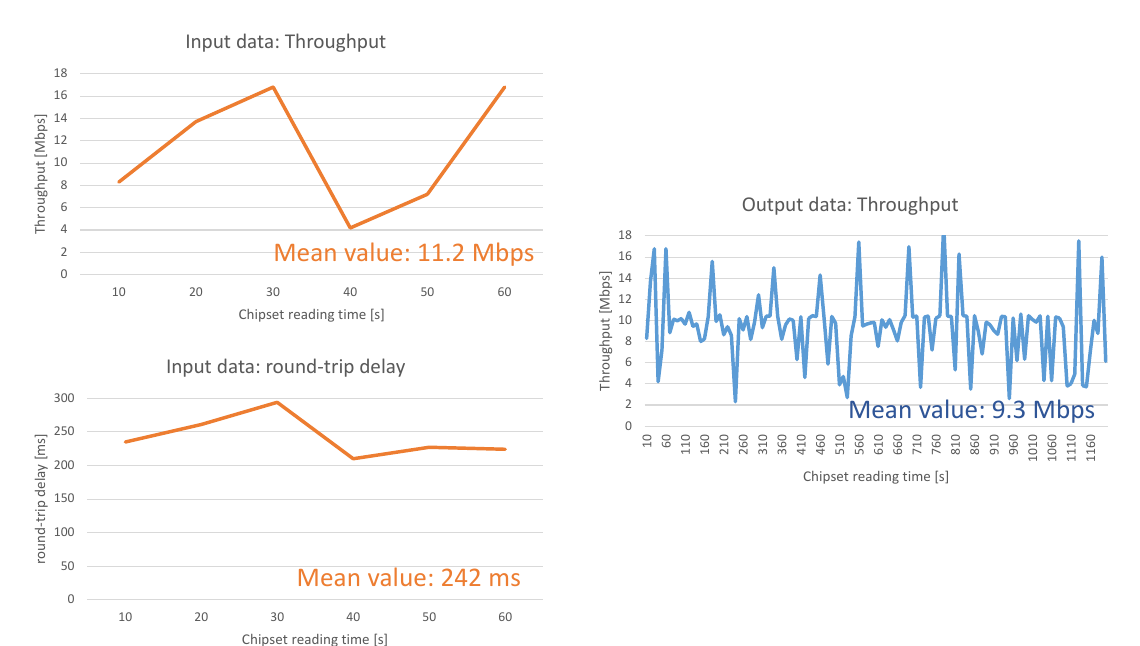
Figure 4. Input and Output data of ML 1 . Input data are throughput and round-trip delay (RTD) (1 min). Output is throughput (20 min). The values of <input1,input2;output> for this concrete sample are: <11.2 Mbps,242 ms; 9.3 Mbps>.